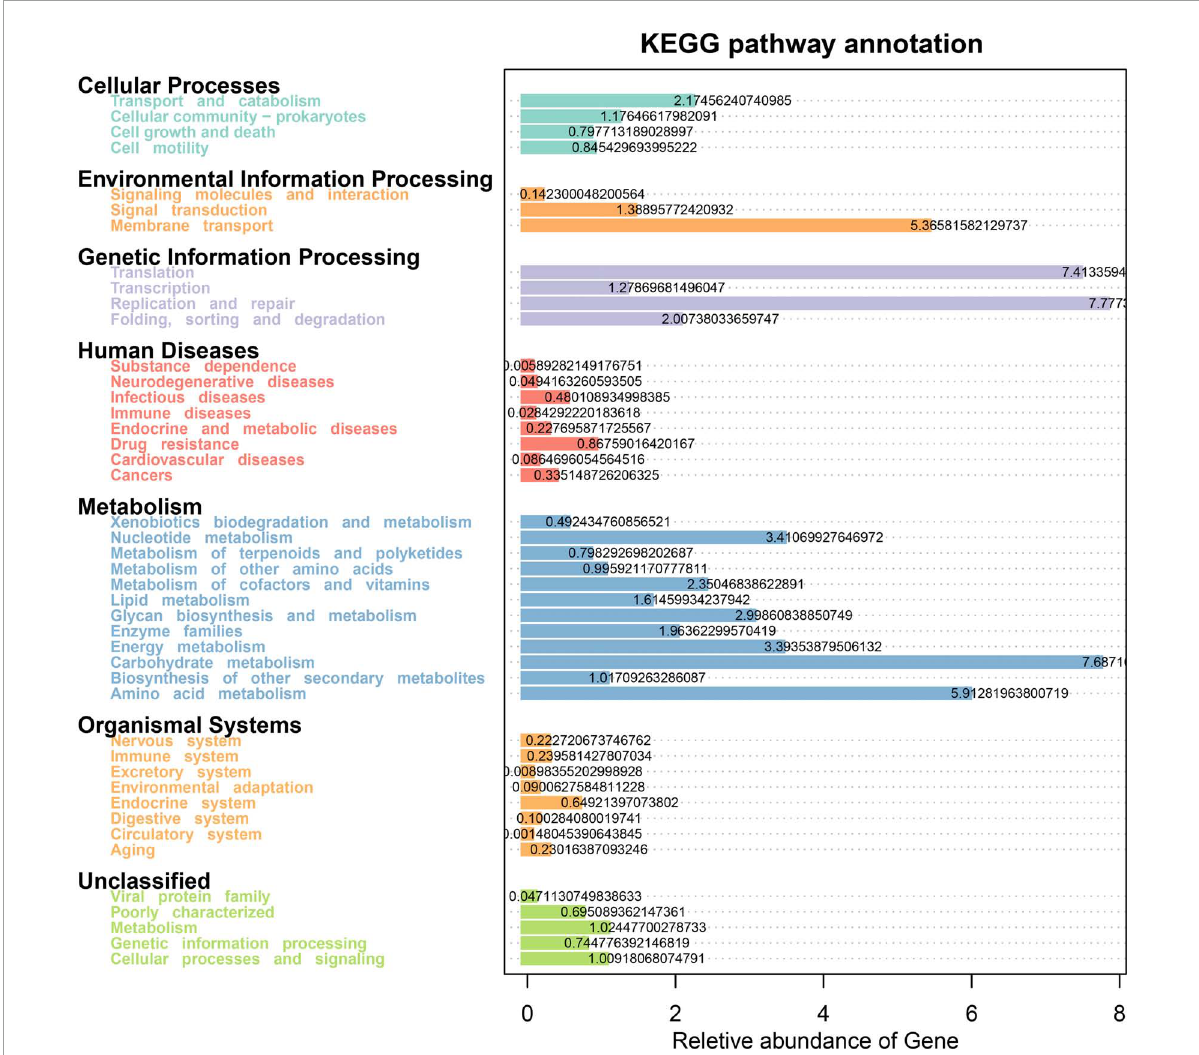
FIGURE7 Tax4Fun predictive analysis of microbial function showing relative abundance of assigned KEGG pathway for the subsystem levels. The X -axis represents the relative abundance of pathways, and the y -axis represents the KEGG